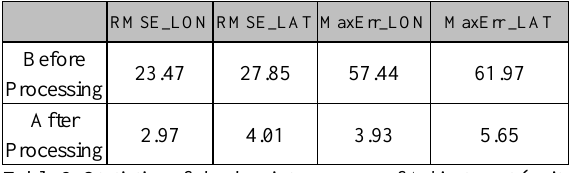
Table 2. Statistics of checkpoint accuracy of Adjustment (unit: m)